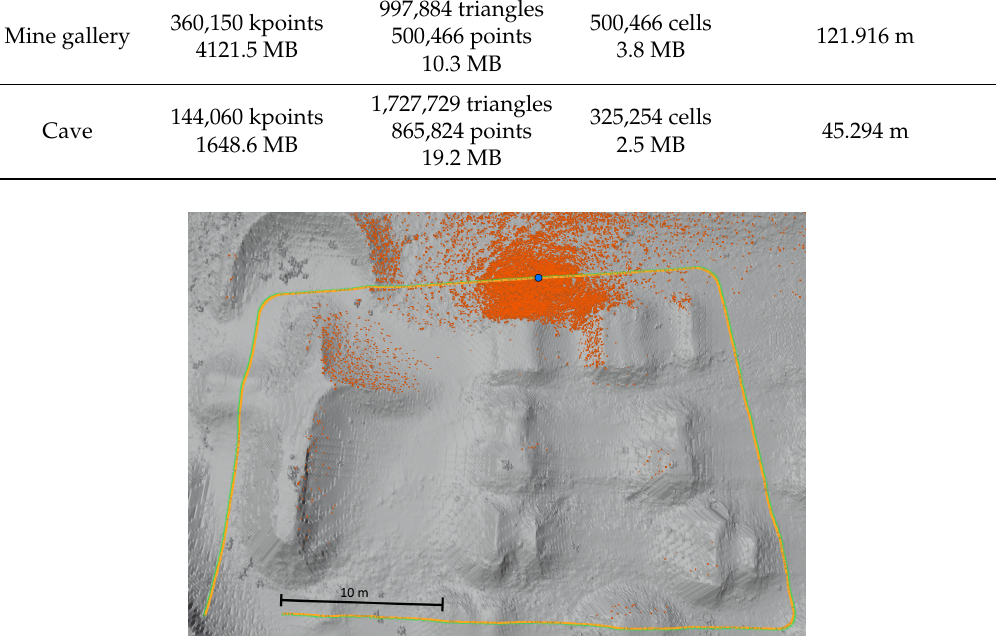
Figure 7. Horizontal cross-section of the point cloud from the mine gallery. The figure shows: the reference scan (gray surface), the measured path of the robot (yellow curve), reference path (green curve), 50,000 scan points captured in 0.1 s during localization (orange dots), localization of the robot when LiDAR was capturing measurement points (blue point).